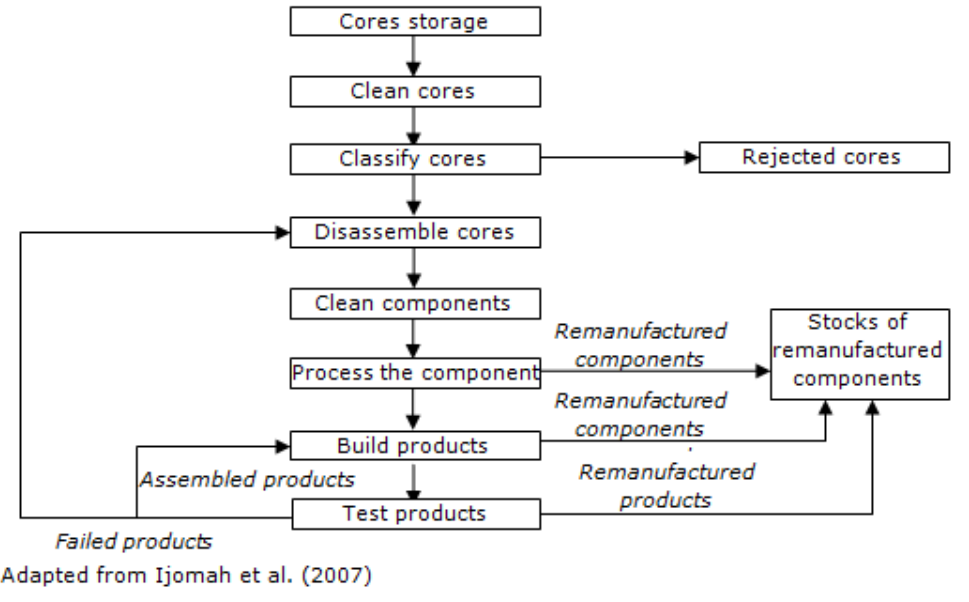
Figure 1. Process of remanufacturing (Ijomah, McMahon, Hammond & Newman,